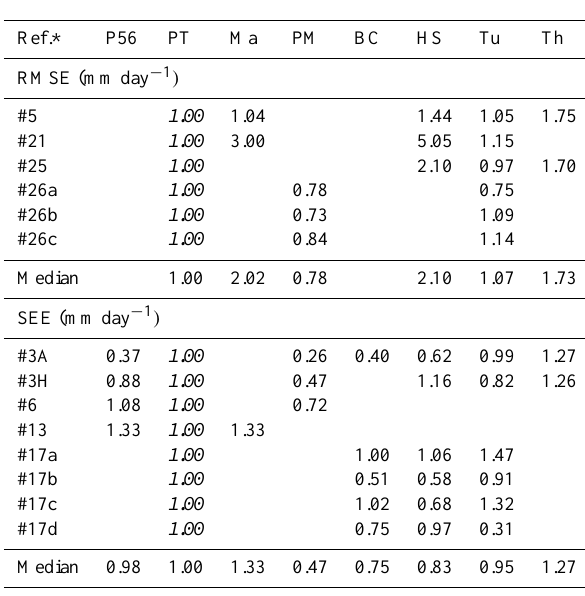
Table 7. Consolidated list of uncertainty estimates as RMSE or SEE expressed as ratio of the equivalent values estimated for